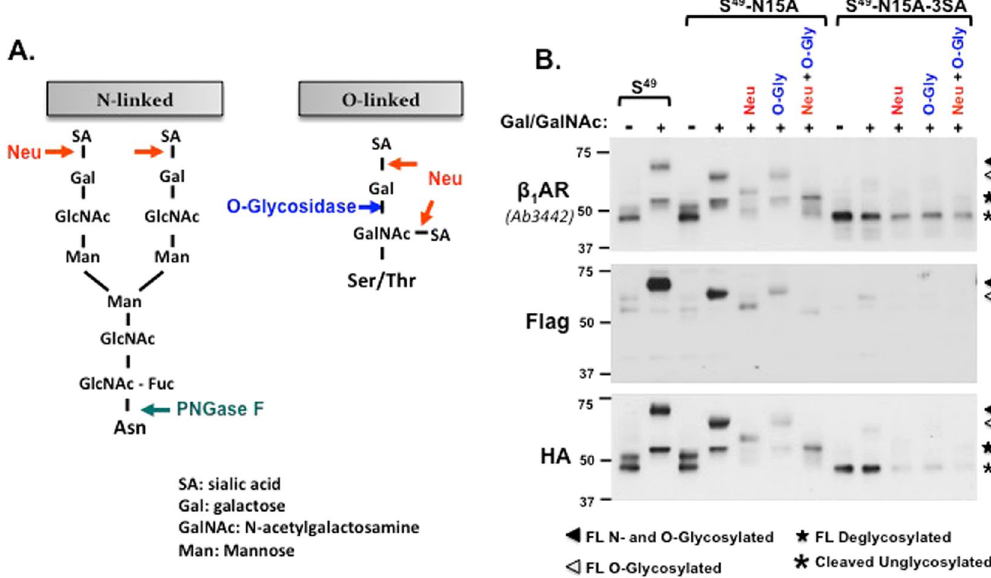
Figure 4. β 1 ARs carry sialylated N- and O-linked glycans that are released by enzymatic deglycosylation. Panel A : Schematics showing cleavage sites in representative N- or O-linked glycan structures. Enzymatic deglycosylations were performed with Neuraminidase (Neu), O-Glycosidase (O-Gly), and Peptide-N- glycosidase F (PNGase F). Panel B: Lysates from ldlD cells transfected with S 49 - β 1 AR, S 49 - β 1 AR-N15A, or S 49 - β μ M) and GalNAc (200 μ M) were subjected to deglycosylation 1 AR-N15A-3SA cultured without or with Gal (20 protocols as described in Methods. Lysates were then probed with antibodies that recognize C-terminal epitopes (anti-